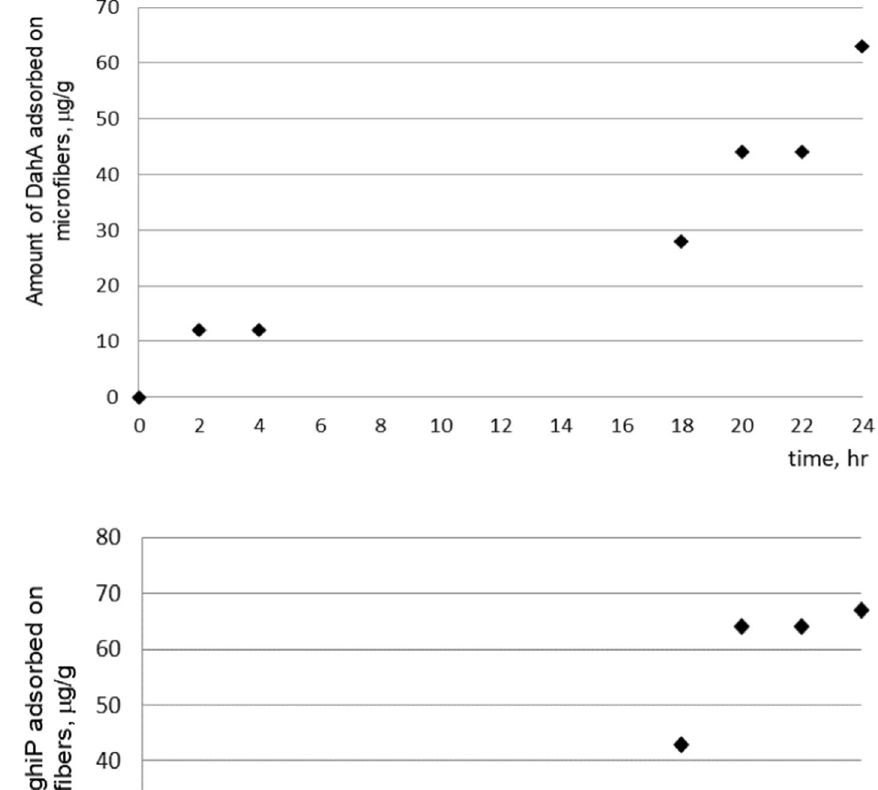
Fig. 6 Dibenzo(ah)anthracene (μg/g) adsorbed on microfibers as a function of time